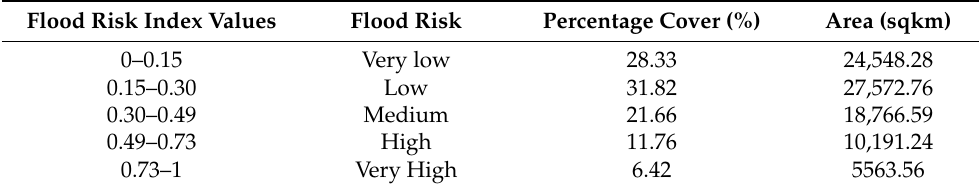
Table 4. Flood risk area and percentage coverage.